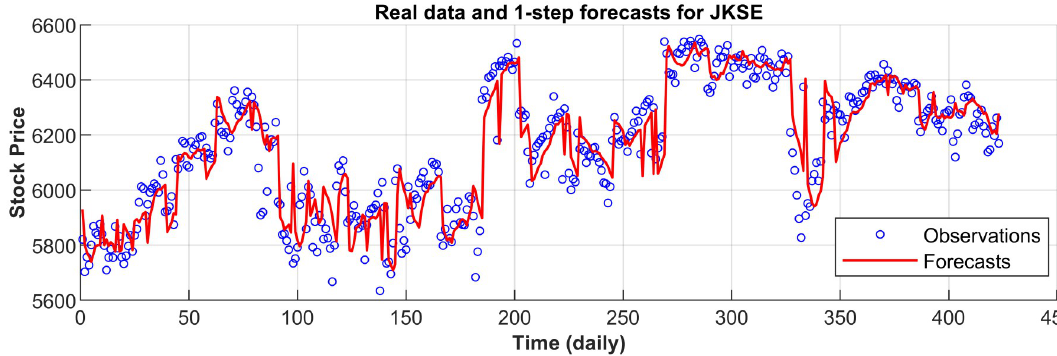
Fig 11. 1-step forecasts of the nPRM and market values for Indonesia JKSE.